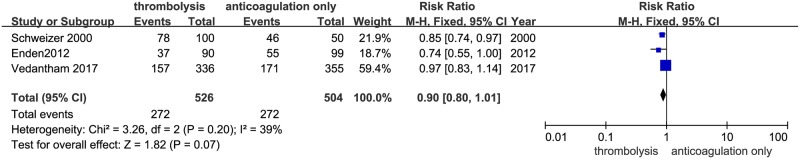
Thrombolysis + anticoagulation group vs. anticoagulation-only group on the outcomes of PTS.